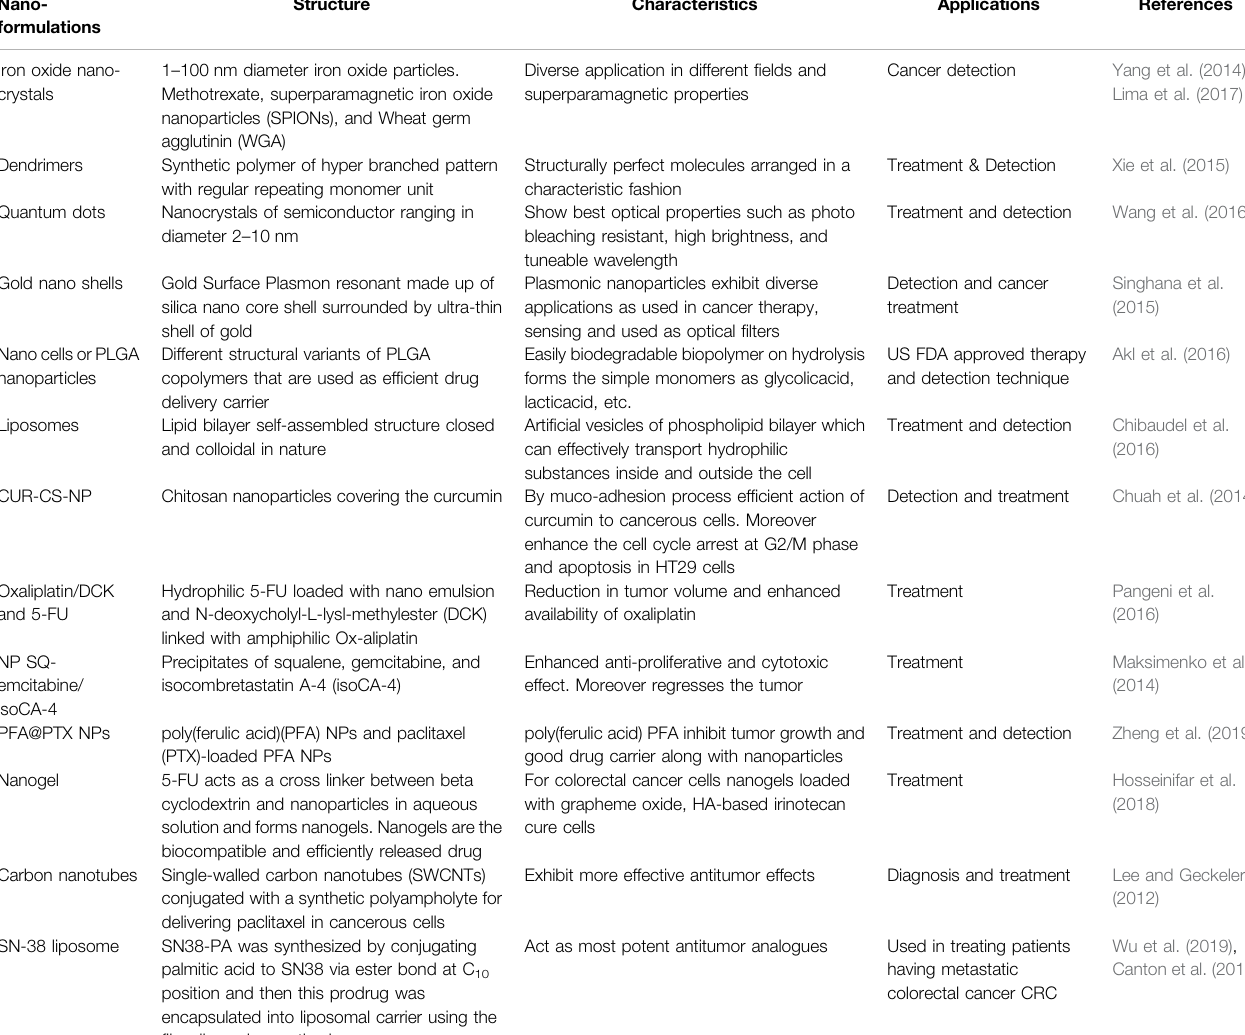
TABLE 3 | Summary of nano formulations used in the detection and treatment of